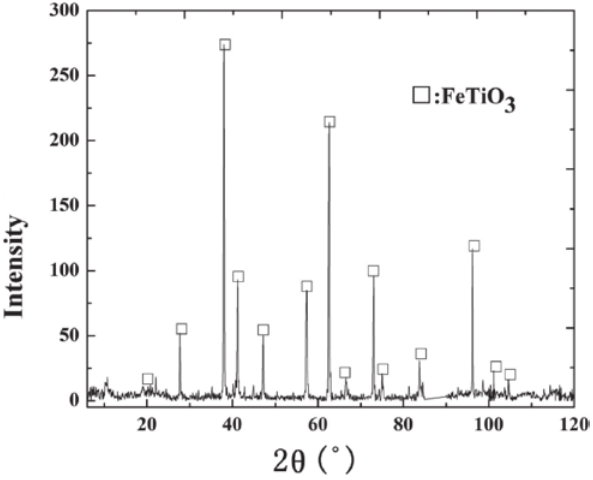
Fig. 1: X-ray diffraction of ilmenite